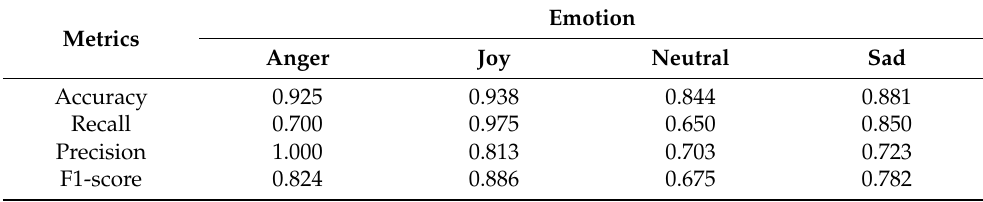
Table 6. Per-class scores in multi-class classification, extended expert’s feature set with 33 samples in total.